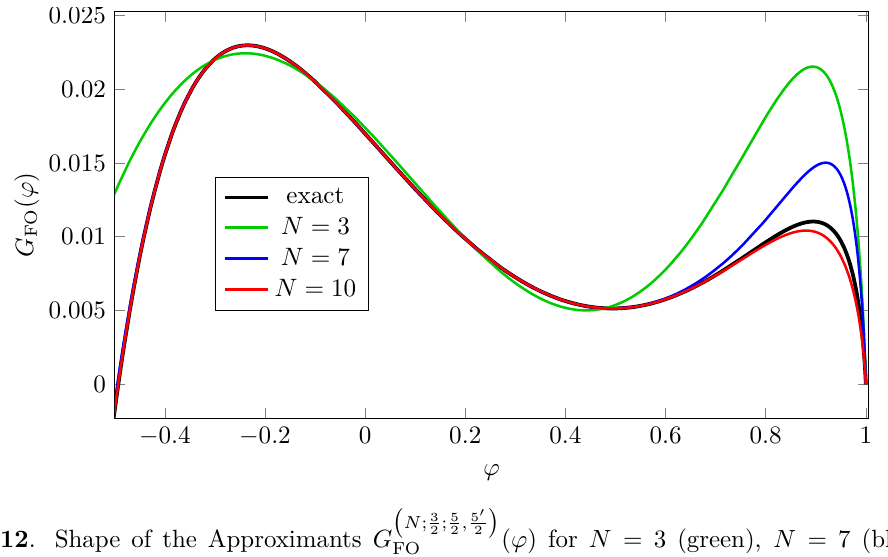
(cid:0) (cid:1) N ; 3 ; 5 , 5 0 ( ϕ ) for N = 3 (green), N = 7 (blue) and 2 2 2 FO ( ϕ ) (black). The model function FO